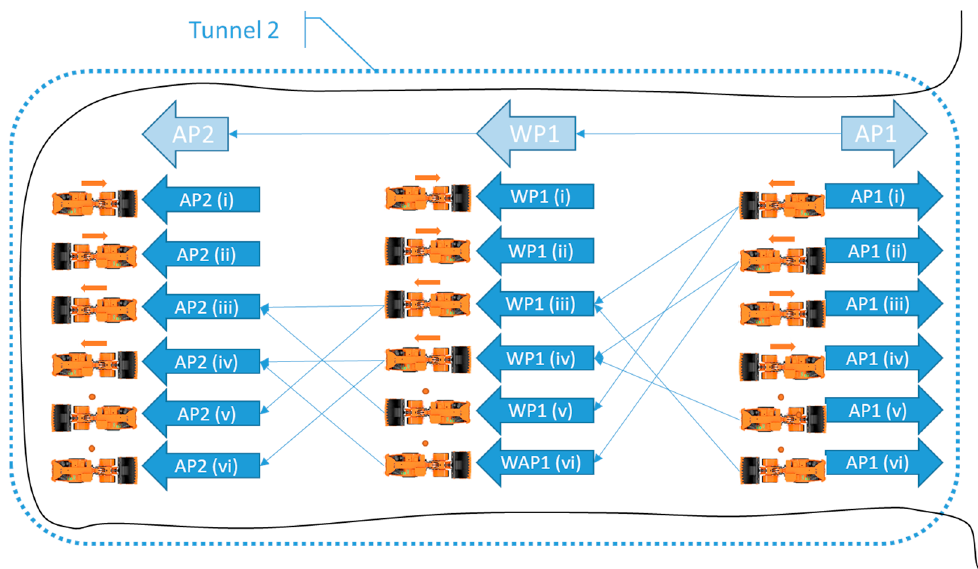
Figure 6. TMM construction example. Connections heading in the same direction of the Tunnel are shown.